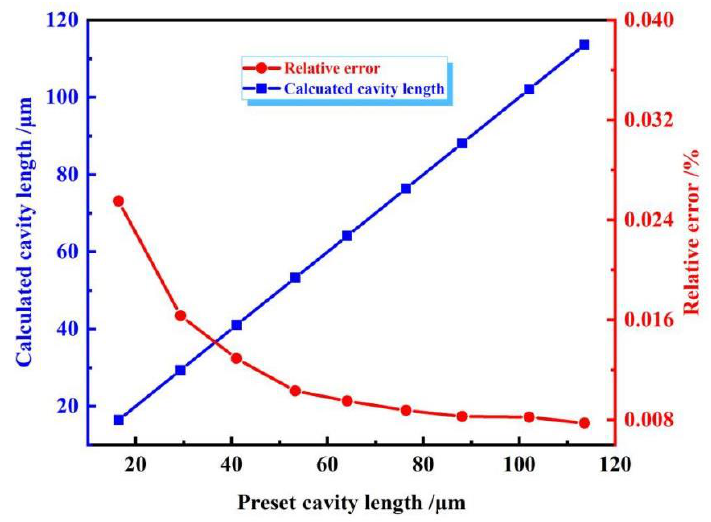
Figure 7. Relationships of the demodulated cavity length ( left ) and demodulation error ( right ) versus the standard cavity length.